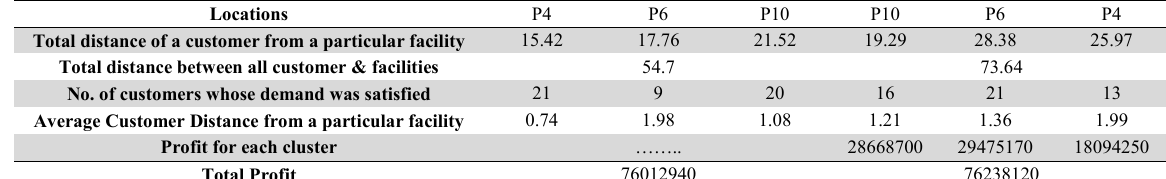
Number of clusters = 3